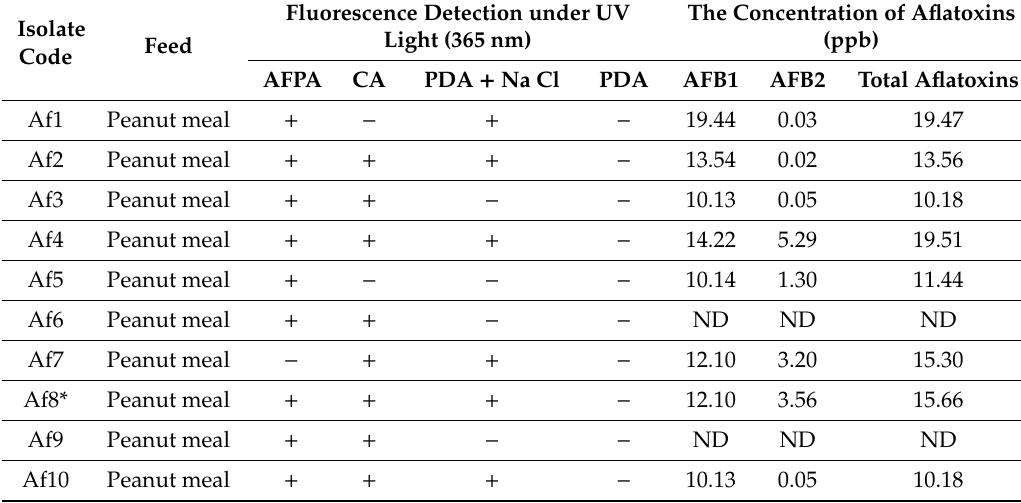
Table 1. Fast screen aflatoxins by various cultural media and concentration of aflatoxins assayed